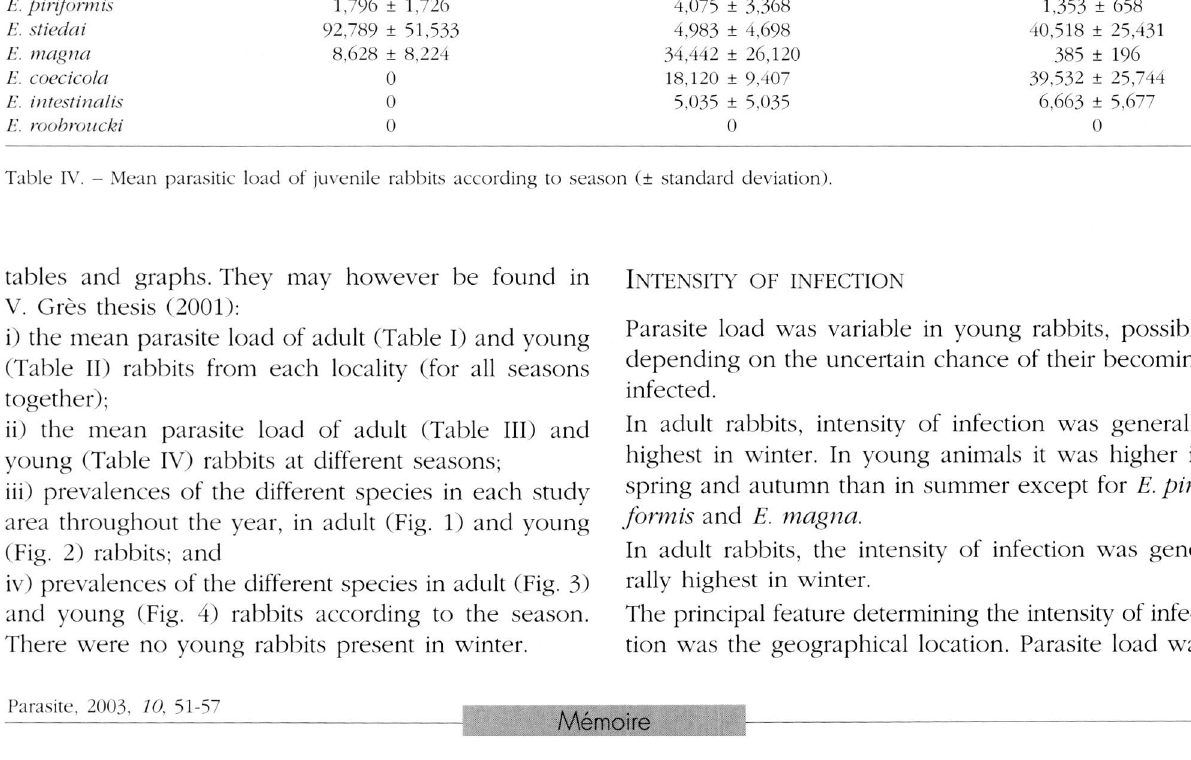
Table III. - Mean parasitic load of adult rabbits according to season (± standard deviation).